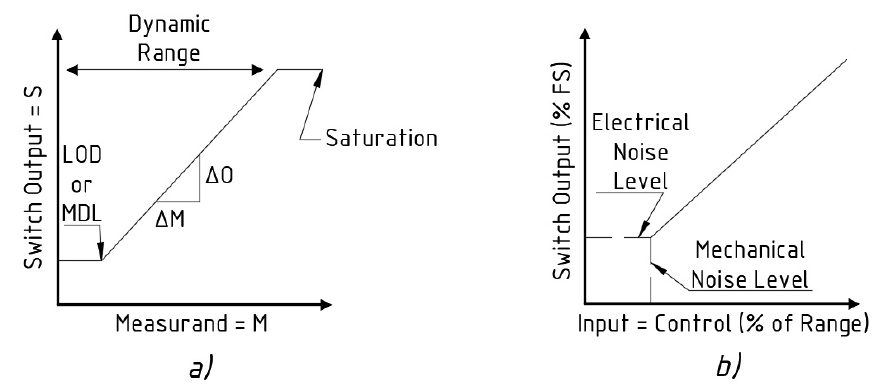
Figure 10. Calibration curves: ( a ) schematic of a calibration curve for a sensor or an analytical instrument. Calibration curves need not be linear over their dynamic ranges, as shown here. Both axes can be either linear or logarithmic; ( b ) schematic of the control curve for an actuator. Control curves are often nonlinear and sometimes hysteretic, in which case the output for a given input can be double valued. The axes for control curves of actuators are generally linear.Adapted from